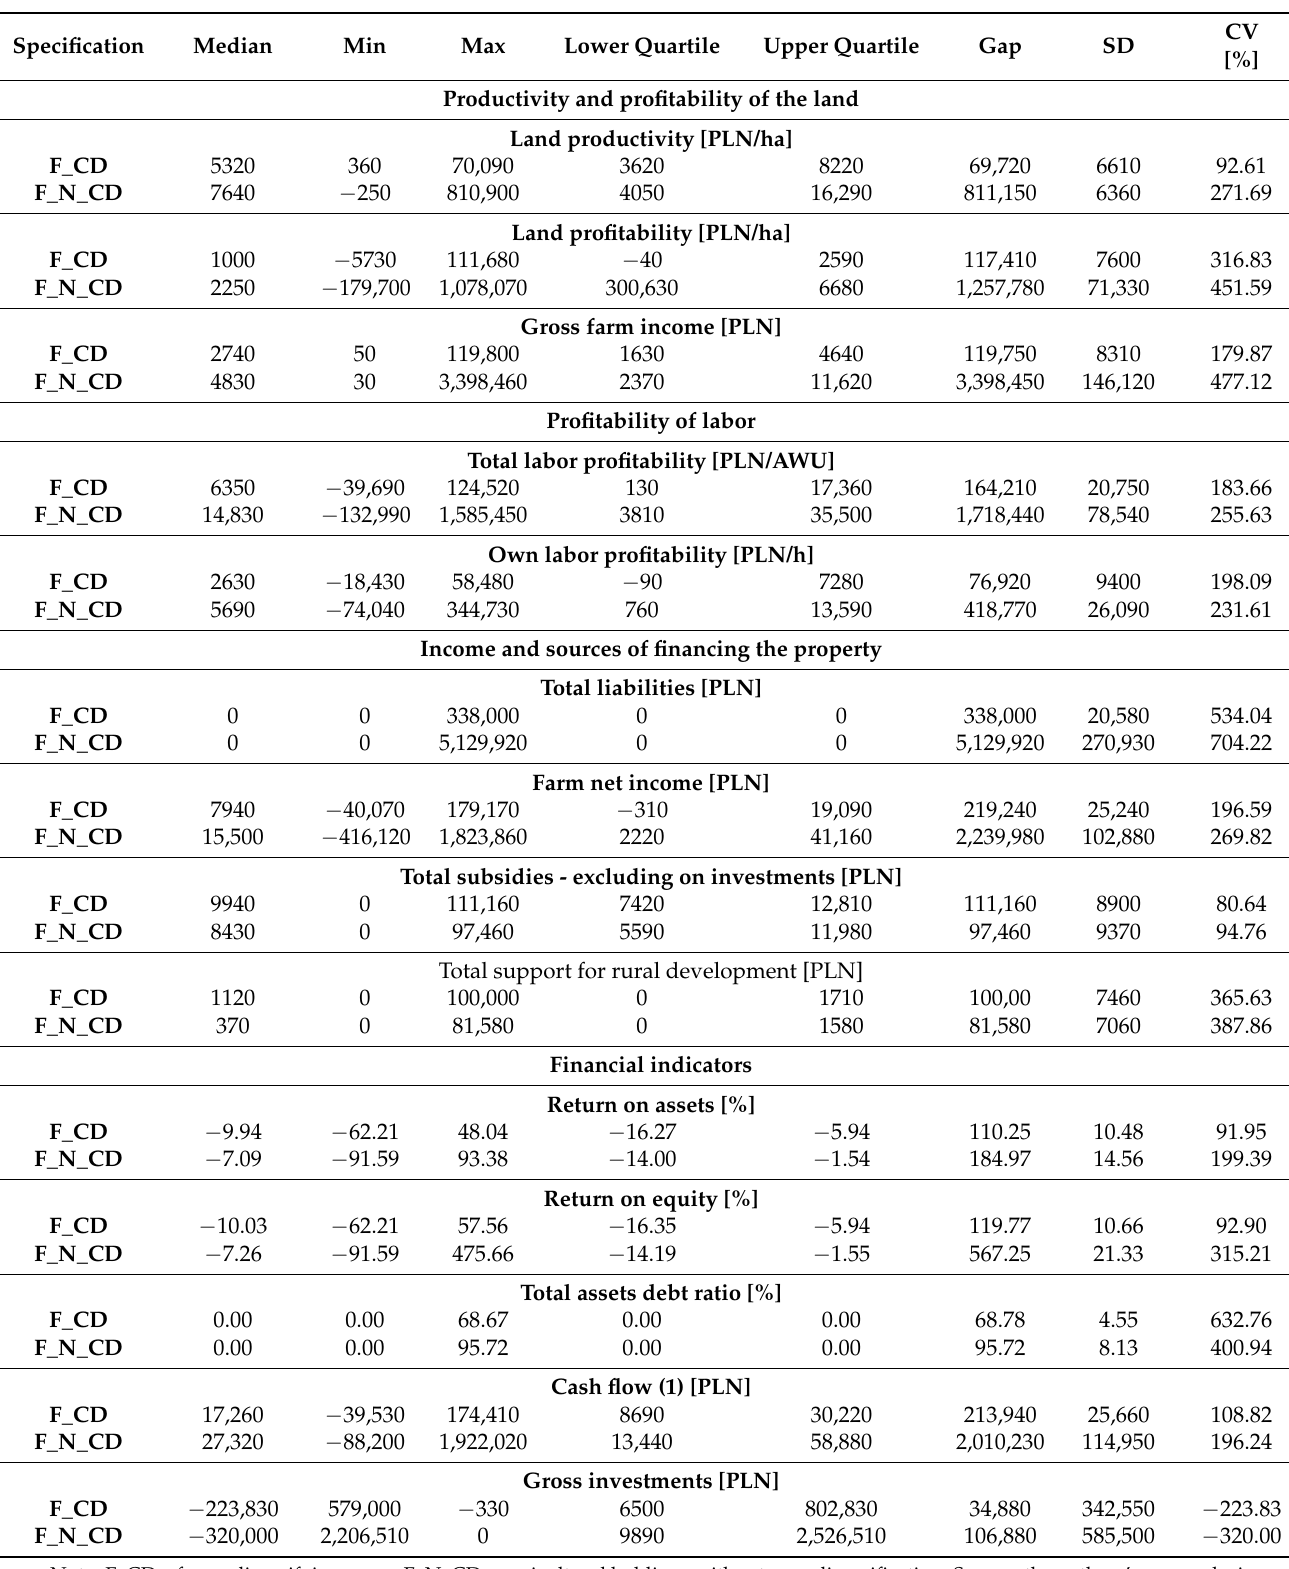
Table 3. Economic results of small farms due to crop